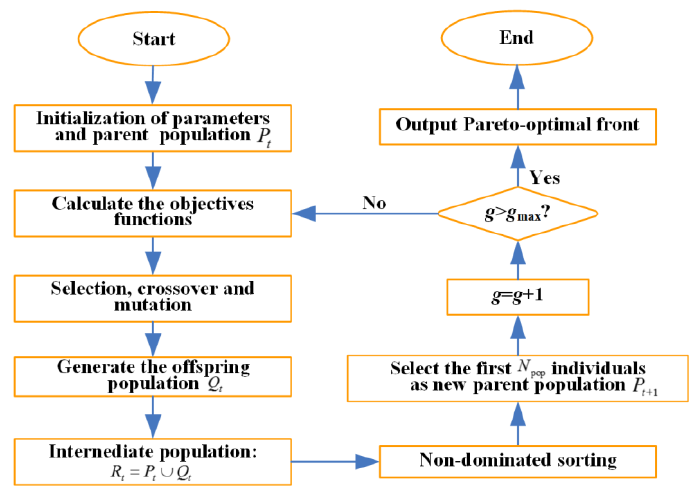
Figure 3. Flowchart of the NSGA-II algorithm.